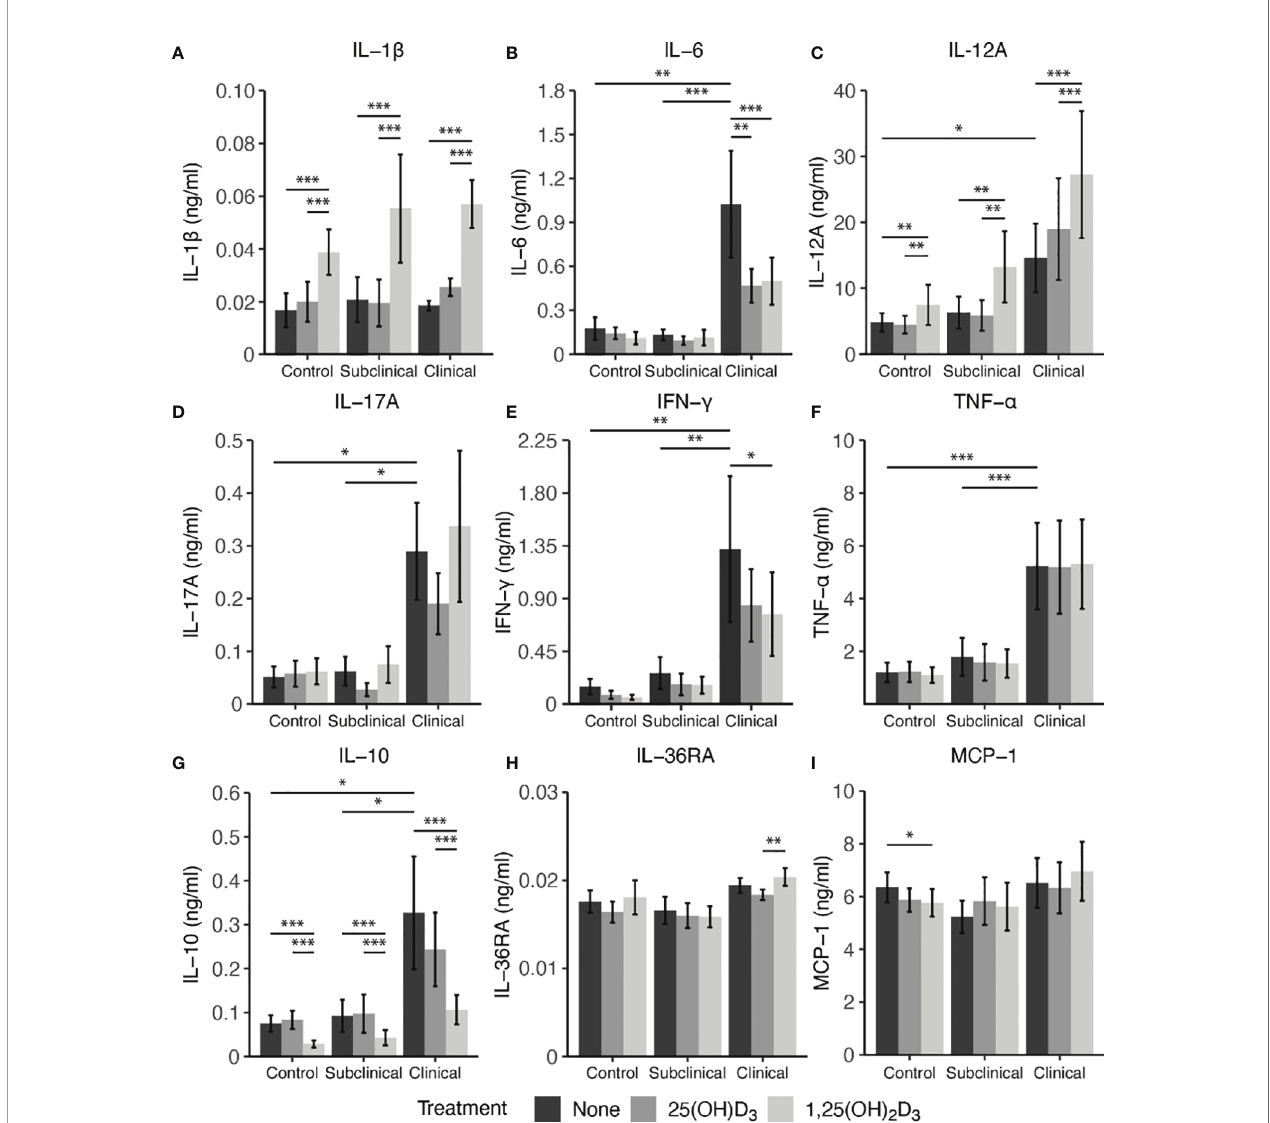
FIGURE 7 | Cytokine expression from monocyte-derived macrophages (MDMs) co-cultured with peripheral blood mononuclear cells (PBMCs) from naturally infected dairy cattle (clinical n=7, subclinical n=7) or noninfected controls (n=9). PBMCs isolated from whole blood were cultured 5-6 days to generate MDMs, pre-treated with vitamin D 3 as detailed in methods, then incubated 24 hrs with live MAP (10:1 MOI) ± 25(OH)D 3 or ± 1,25(OH) 2 D 3 . Protein concentrations were determined from cell culture supernatants using Milliplex magnetic bead assay for (A) IL-1 b , (B) IL-6, (D) IL-17A, (E) IFN- g , (F) TNF- a , (G) IL-10, (H) IL-36RA, (I) MCP-1, while (C) IL-12A was measured using standard ELISA. Data are presented as the mean ± SE and signi fi cance levels are de fi ned as * < 0.05, ** < 0.01, *** <